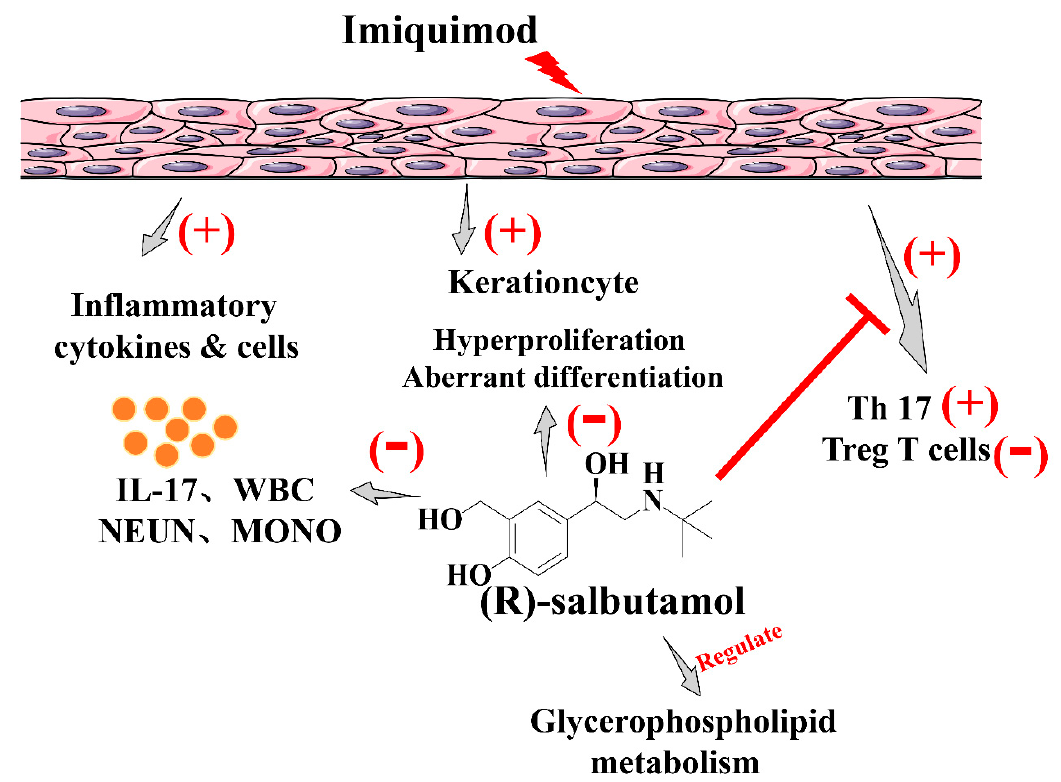
Figure 9. Schematic diagram showing possible mechanisms responsible for the pharmacological efficacy of ( R )-salbutamol. Oral administration of ( R )-salbutamol markedly reduced the plasma levels of IL-17, decreased the proportion of CD4+ Th17+ T cells (Th17) whereas increased the percentage of CD25+ Foxp3+ regulatory T cells (Tregs) in the spleens, and affected glycerophospholipid metabolism. Figure S1: Potential biomarkers identified by UHPLC-TIMS-TOF MS / MS, Table S1: Psoriasis area and severity index (PASI) score, Table S2: Pathological score by Baker score system, Table S3: QC samples-based investigation of the analytical methods, Table S4: Potential biomarkers of anti-psoriasis in ( R )-salbutamol-treated IMQ-induced mouse psoriasis obtained from UHPLC/ESI-TIMS TOF-MS/MS.